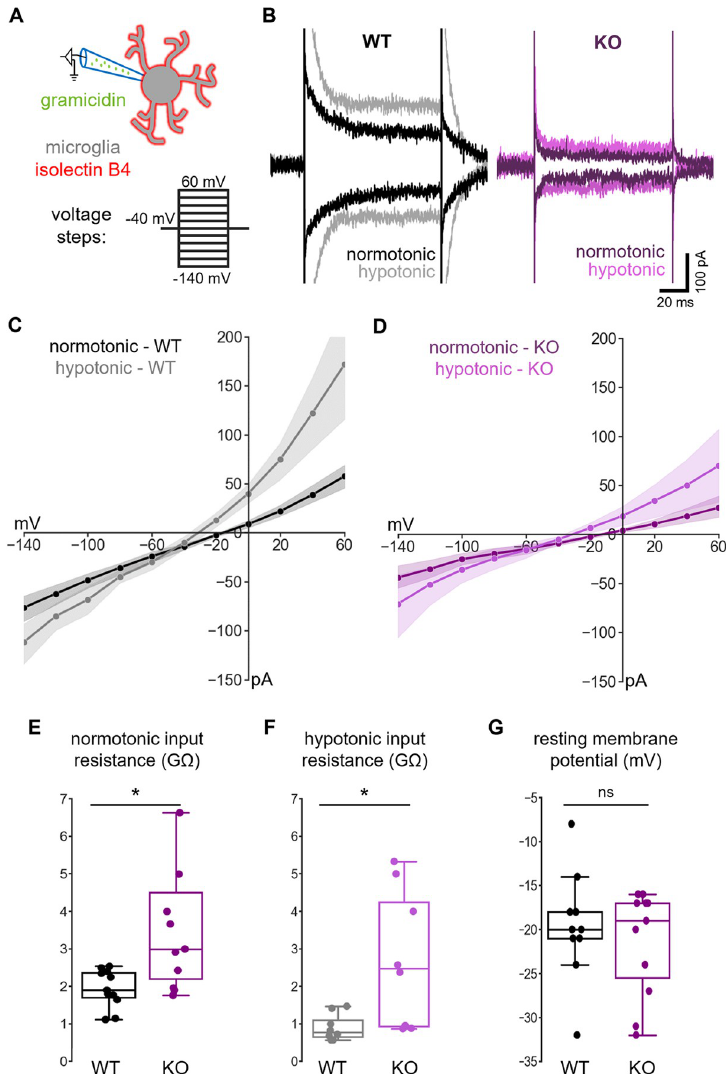
Fig 5. Deletion of NKCC1 from microglia results in altered membrane currents. (A) Schematic representation of the experiment. Perforated patch-clamp recordings were performed on isolectin B4–labeled microglial cells in acute hippocampal slice preparations. Current responses to a train of voltage steps from − 140 to 60 mV with 20 mV increments and a duration of 100 ms were measured in voltage-clamp mode (holding potential: − 40 mV) both in normotonic, and after 5-minute perfusion with hypotonic ACSF (50% dilution). ( B) Example traces of recordings from WT (black: normotonic, gray: hypotonic ACSF) and NKCC1 KO (purple: normotonic, violet: hypotonic ACSF) animal. Traces show responses at − 140 and +60 mV voltage steps in both conditions. ( C) Average I-V curve responses from WT in normotonic ( N = 11 cells, black with SEM) and in hypotonic ( N = 8 cells, gray with SEM) condition. ( D) Average I-V curves from NKCC1 KO in normotonic ( N = 11 cells, purple with SEM) and in hypotonic ( N = 8 cells, violet with SEM) condition. ( E) Input resistance of WT versus KO cells in normotonic condition. ( F) Input resistance of WT versus KO cells in hypotonic condition. ( G) Resting membrane potential in normotonic condition of WT versus NKCC1 KO microglial cells measured in current-clamp mode (0 pA injected current). ( E) Mann–Whitney; N (WT) = 11 cells from 8 animals, N (KO) = 11 cells from 7 animals; � : p < 0.05. ( F) Mann–Whitney; N (WT) = 8 cells from 6 animals, N (KO) = 8 cells from 5 animals; � : p < 0.05. ( G) Mann–Whitney; N (WT) = 10 cells from 8 animals, N (KO) = 11 cells from 7 animals. Data underlying this figure can be found in S1 Data. KO, knockout; ns, not significant; WT, wild